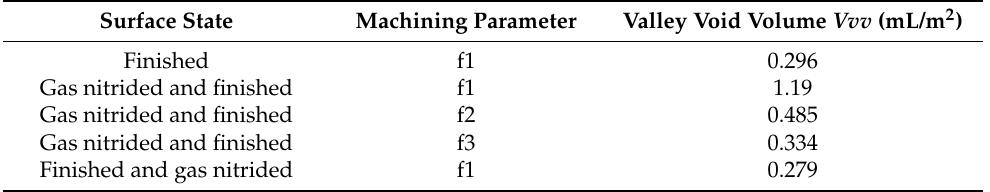
Table 5. Determined valley void volume ( Vvv ) after